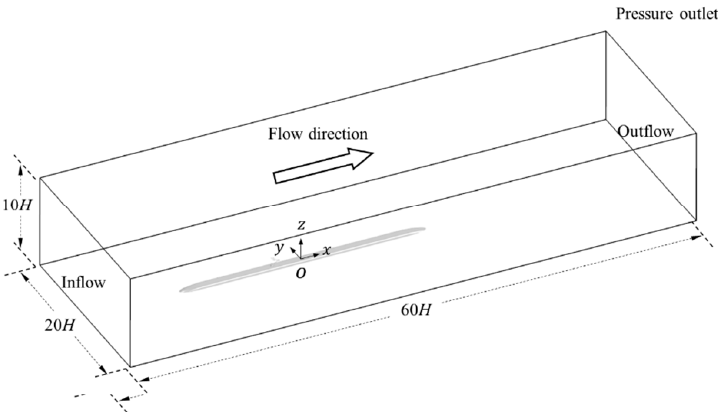
Figure 6. Sketch of the computational domain.